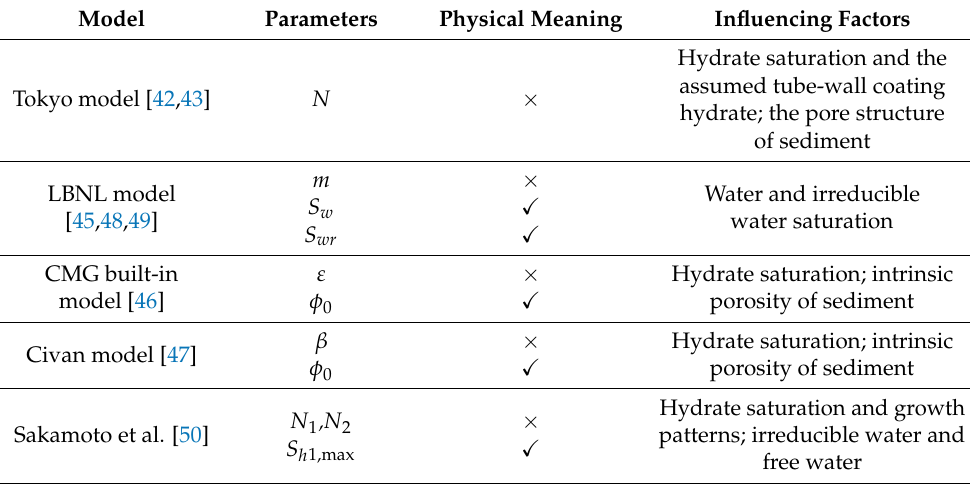
Table 4. Characteristics of reservoir simulator used models for permeability prediction of